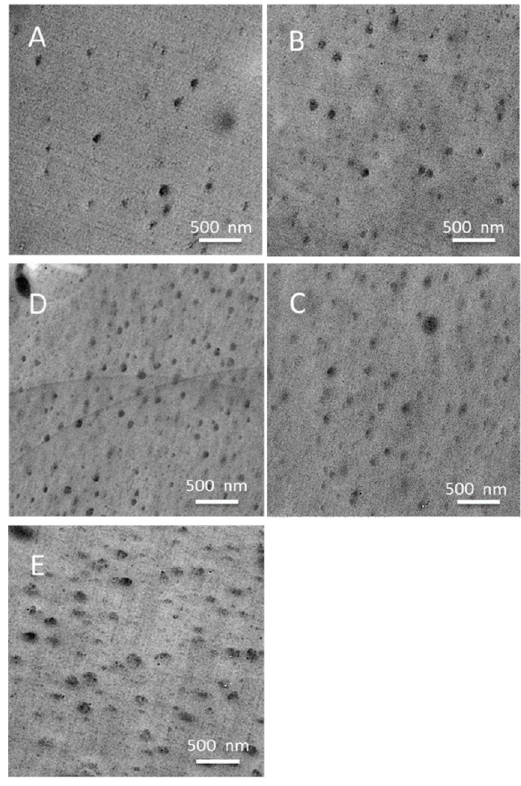
8 Figure 10. ( a ) Thermogravimetric analysis (TGA) thermogram and ( b ) water contact angles of PIs containing various contents of 5,11,14,17-tetranilino DDSQ [81]. Reproduced with permission from Wiley. Zheng et al. [82] reported a facile synthetic method for the preparation of organic/inorganic PI